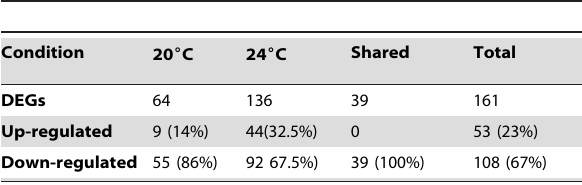
Table 1. Number of DEGs in mussels Mytilus galloprovincialis exposed to heat